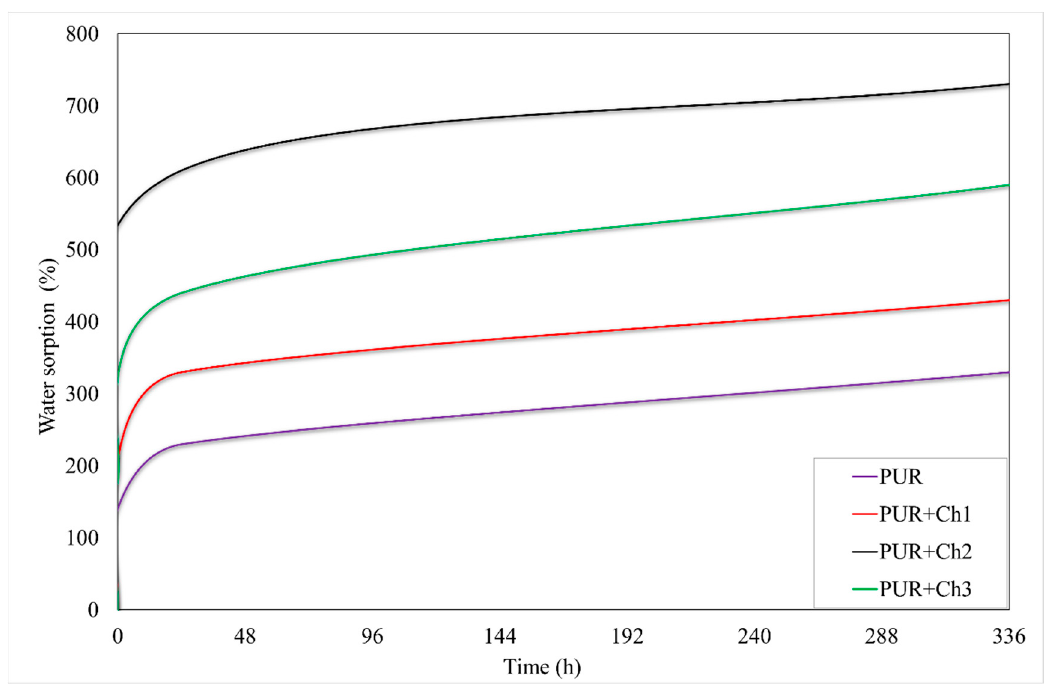
Figure 5. Water sorption of PUR and PUR+Ch foams.